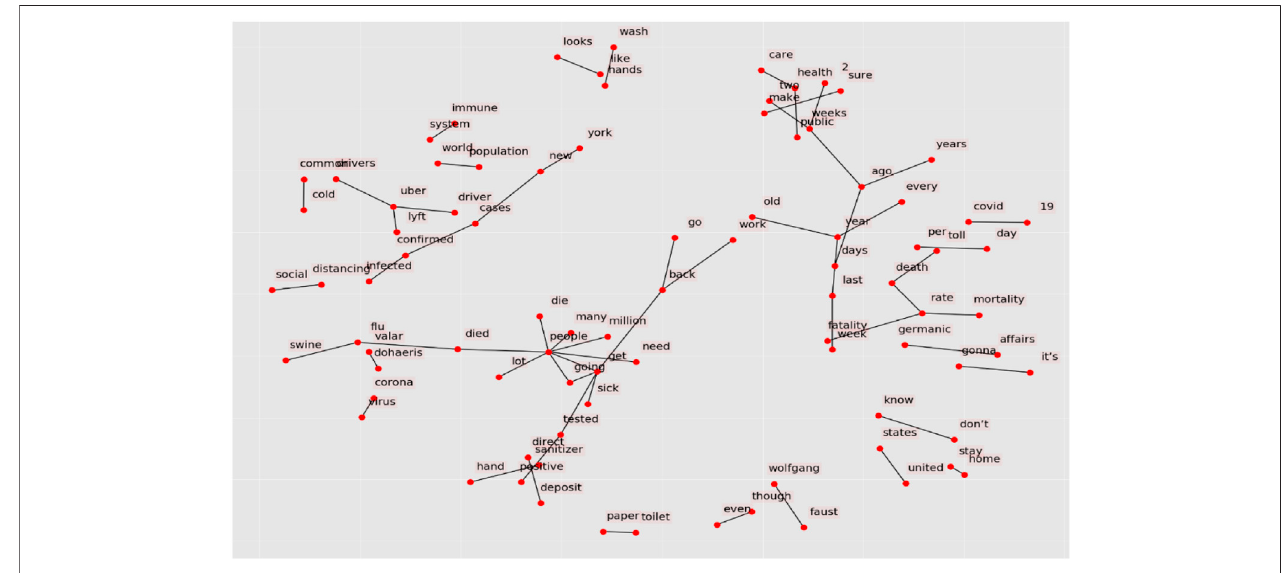
FIGURE 4 | Bigram of Corona forum.